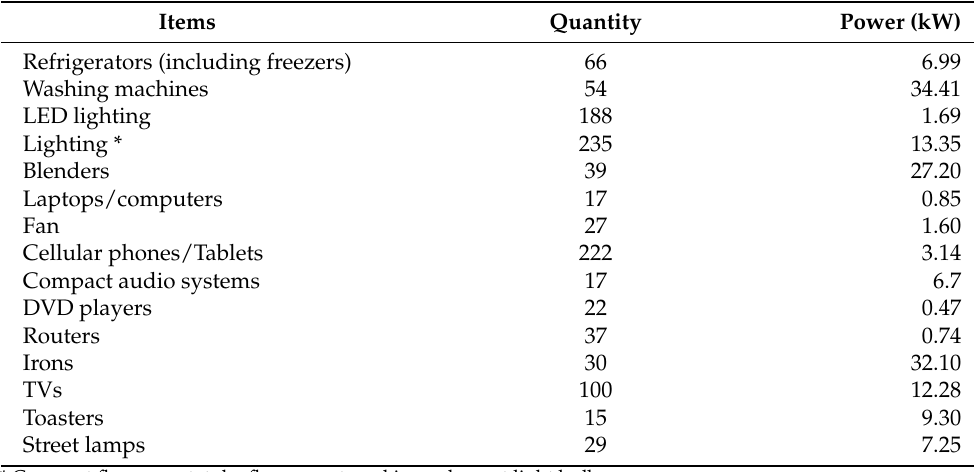
Table 2. Data for the entire community’s electrical